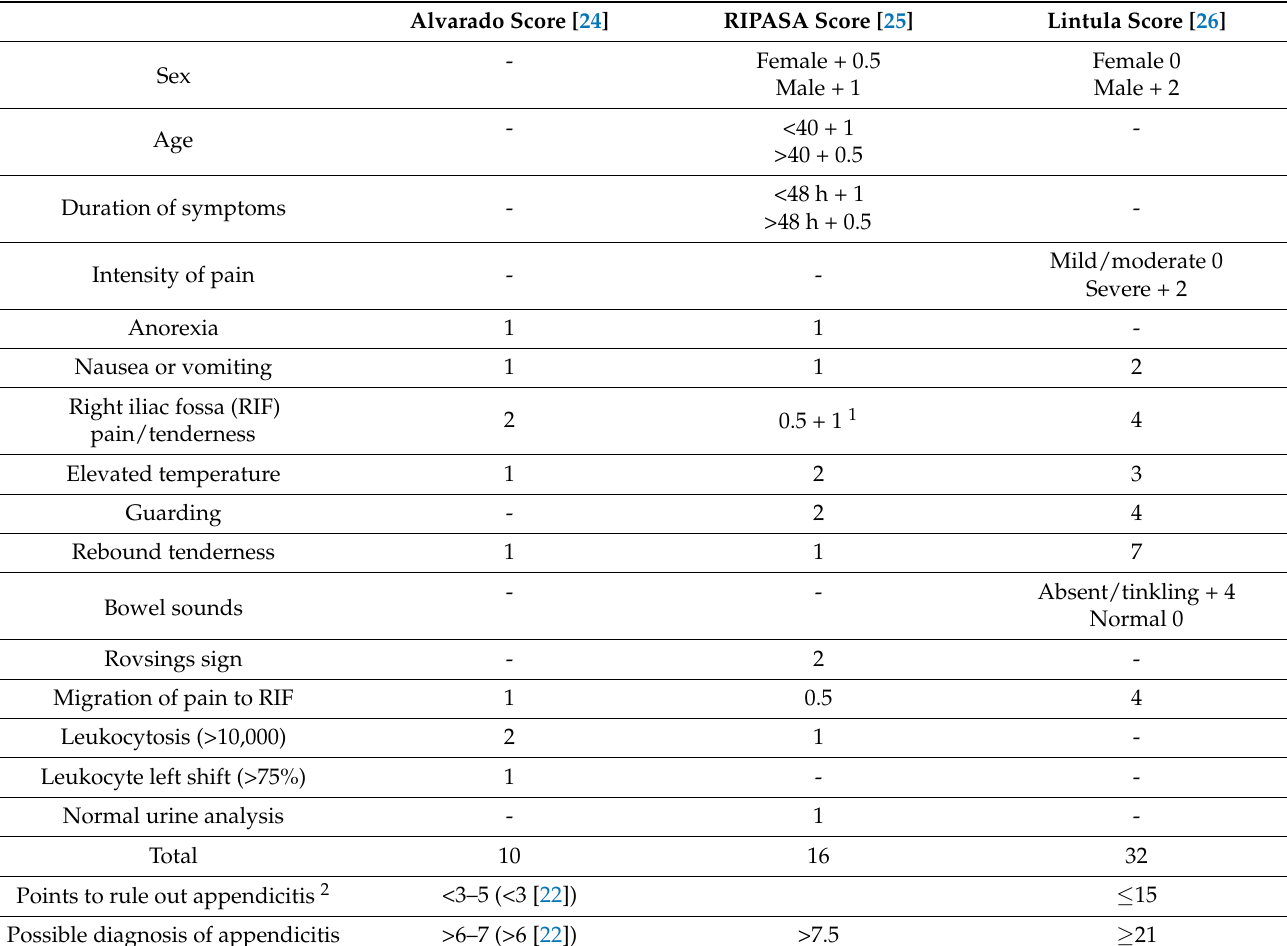
Table 1. Comparison of different scoring systems (Alvarado score, RIPASA score, Lintula